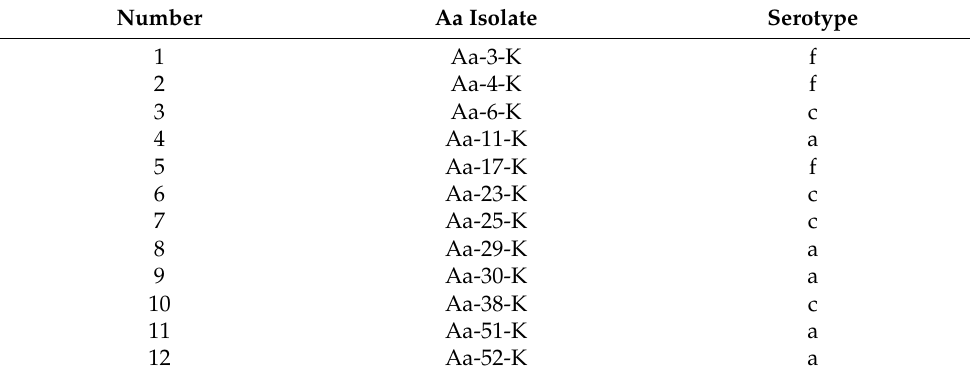
Table 1. Plaque samples for cultivation were collected from 58 of the students examined on the last day of the planned field study. Five samples were discarded due to overgrowth of bacteria and yeast. In 53 of the 58 plaque samples collected, A. actinomycetemcomitans could be detected and isolated in 12 (22.6%) of them. These 12 isolates were serotyped and examined for their leukotoxic activity. Number Aa Isolate Serotype 1 Aa-3-K f 2 Aa-4-K f 3 Aa-6-K c 4 Aa-11-K a 5 Aa-17-K f 6 Aa-23-K c 7 Aa-25-K c 8 Aa-29-K a 9 Aa-30-K a 10 Aa-38-K c 11 Aa-51-K a 12 Aa-52-K